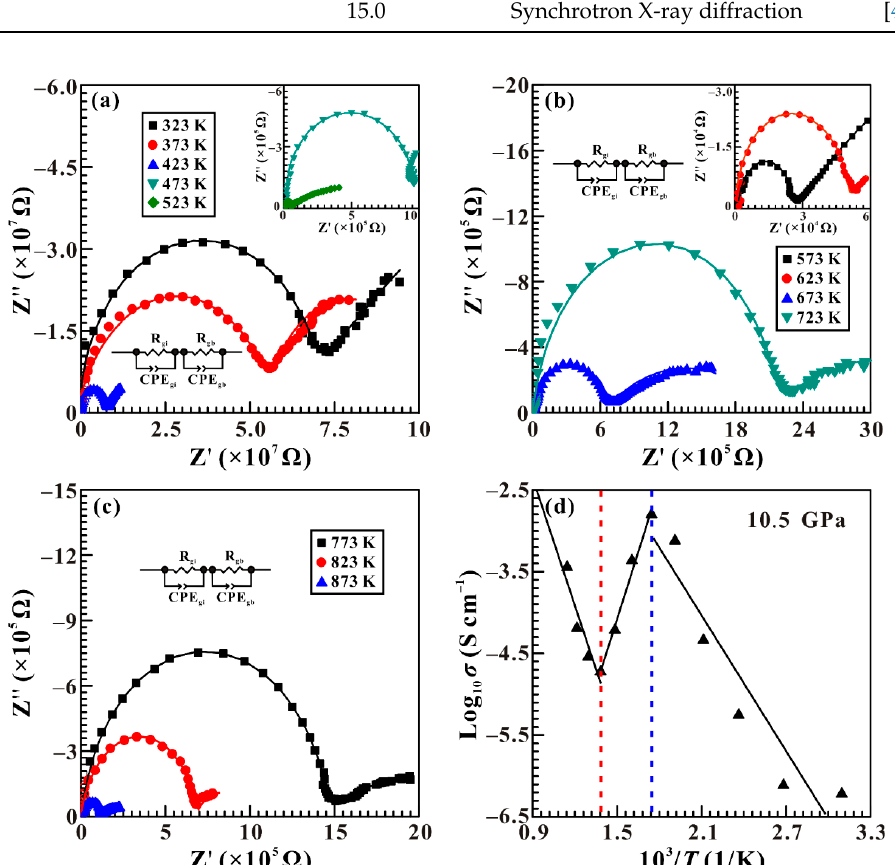
Figure 7. Complex impedance spectra of calcite in the temperature range of 323–873 K at a certain pressure point of 10.5 GPa. ( a ) 323–523 K; ( b ) 573–723 K; ( c ) 773–873 K. ( d ) The logarithmic electrical